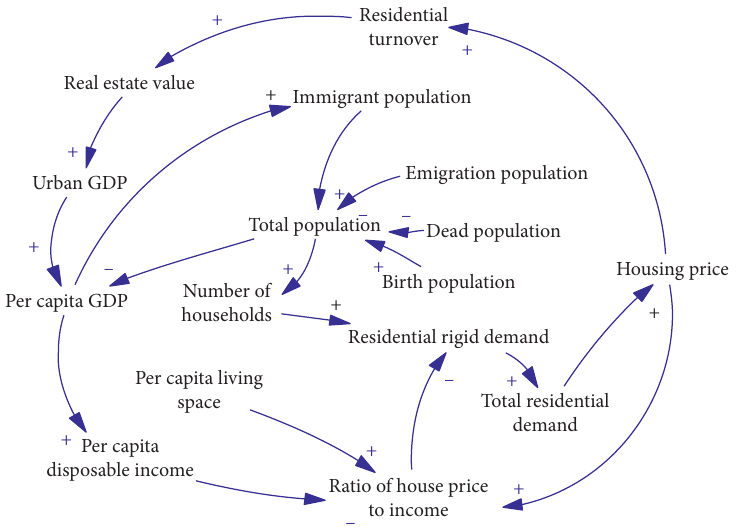
Figure 4: Causality diagram of urban population